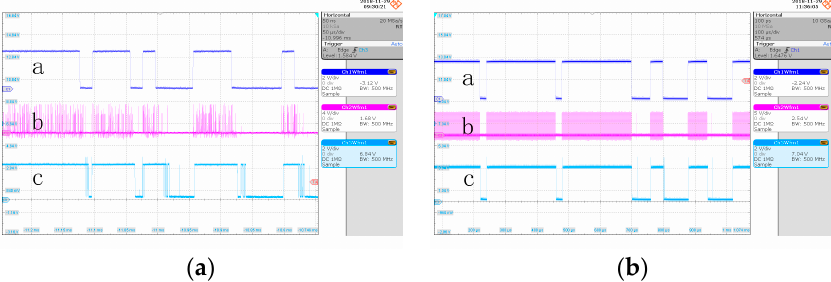
Figure 8. Waveform of underwater photon-counting communication at different BER: ( a ) BER = 0.1530; and ( b ) BER = 0.0210.